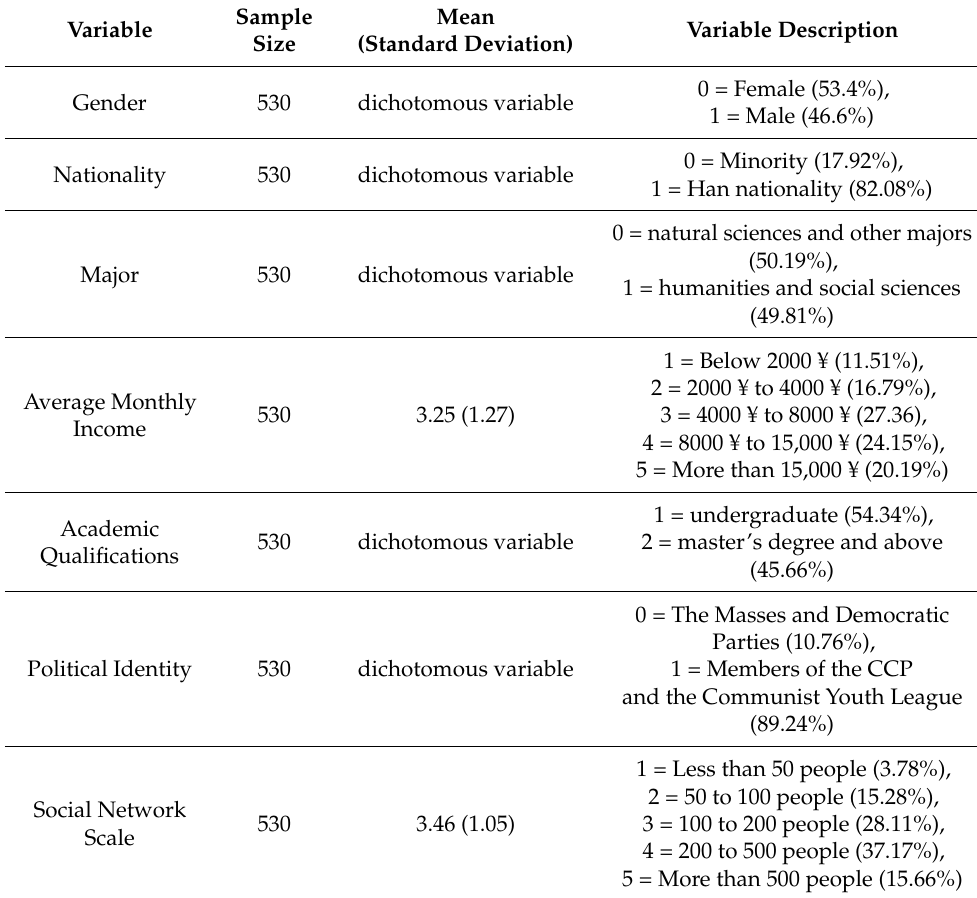
Table 1. The descriptive statistics of the main controlled